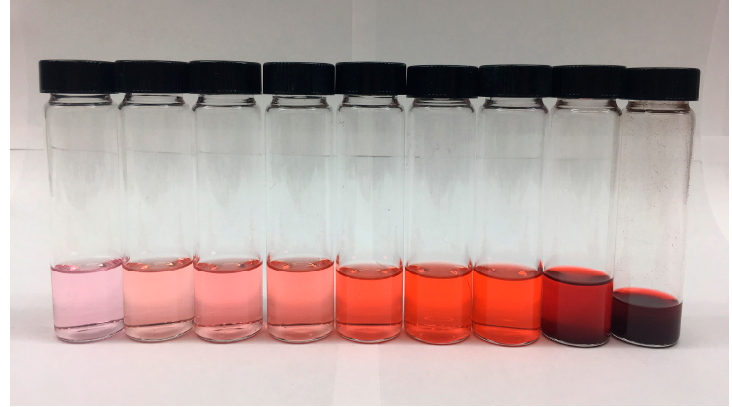
Figure 4. Varying concentrations of the crystal ‘Dramada’ from Scytalidium cuboideum in acetone. Solution concentrations range from 0.024 mM to 19 mM ( left to right ).